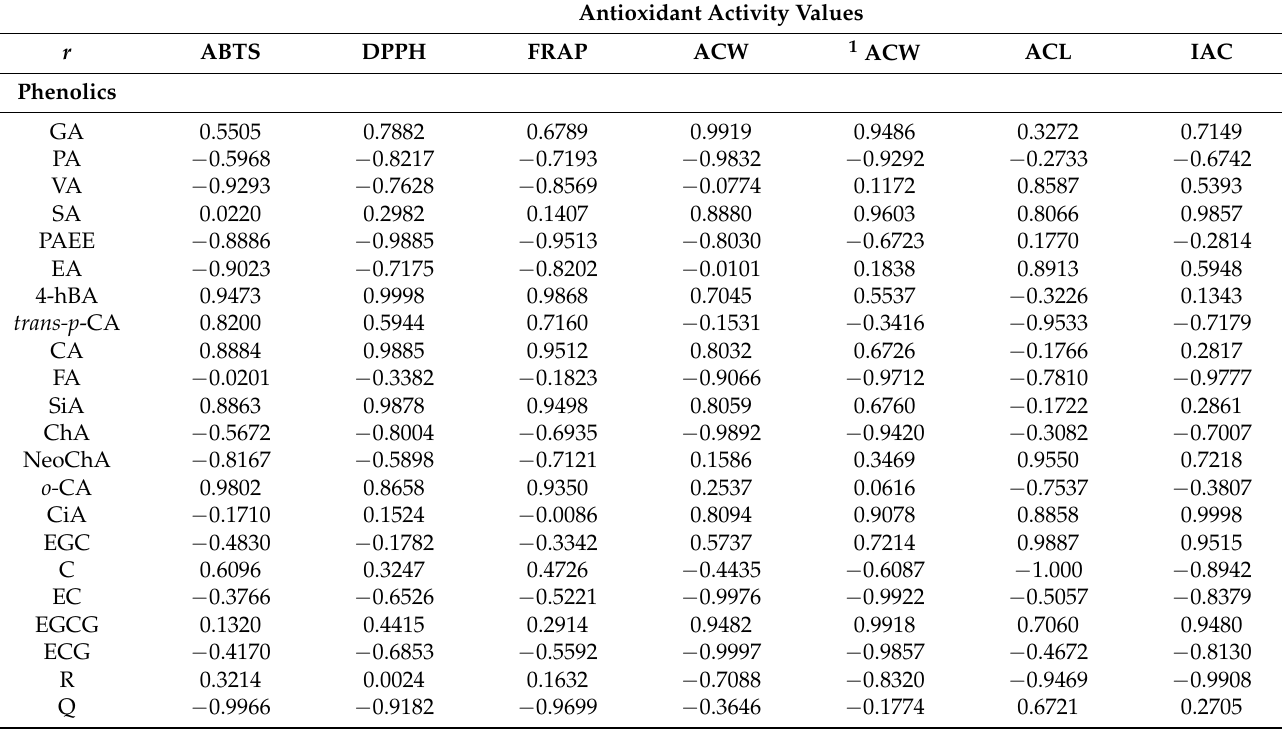
Table 5. The relation of several evaluation parameters of native matcha